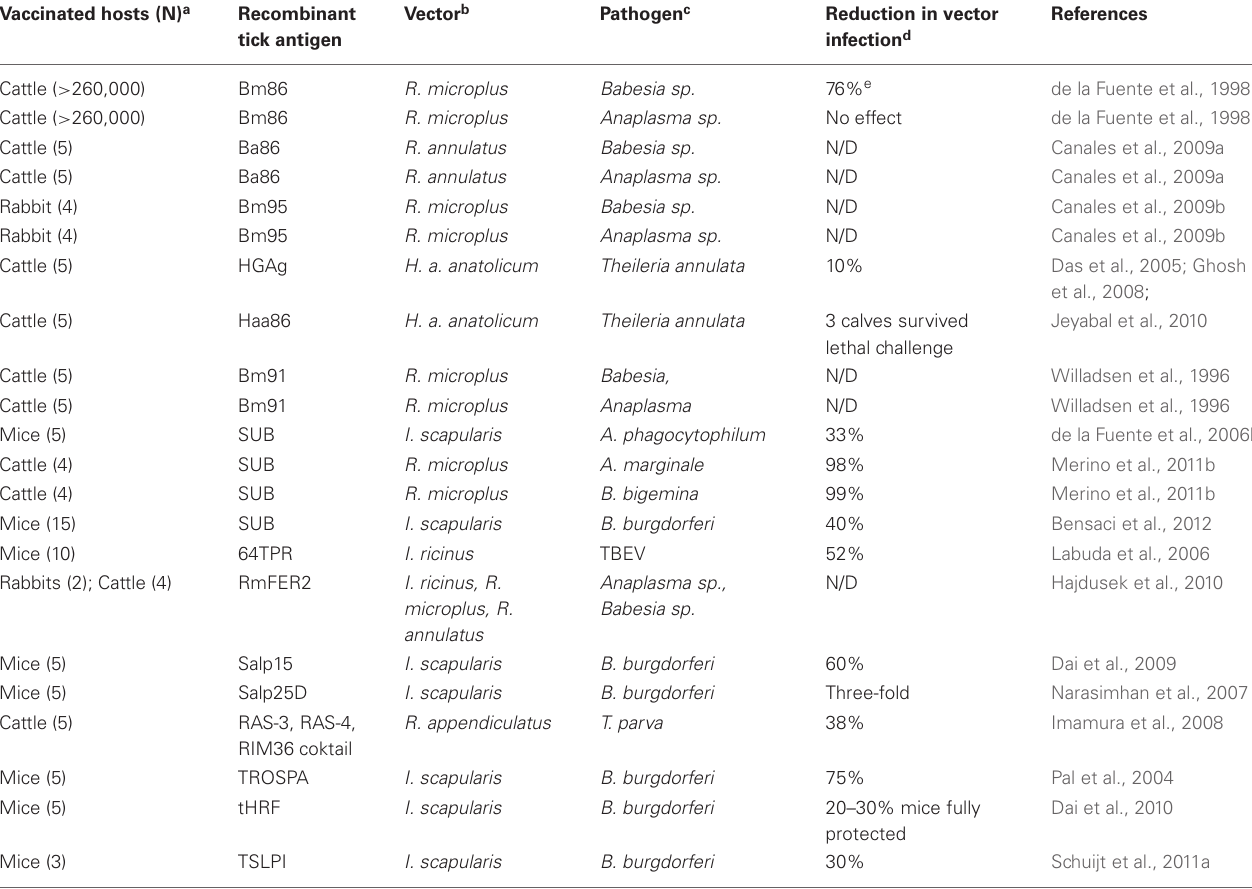
Table 1 | Overview of tick protective antigens and their effect on the control of tick-borne pathogens. Vaccinated hosts (N)